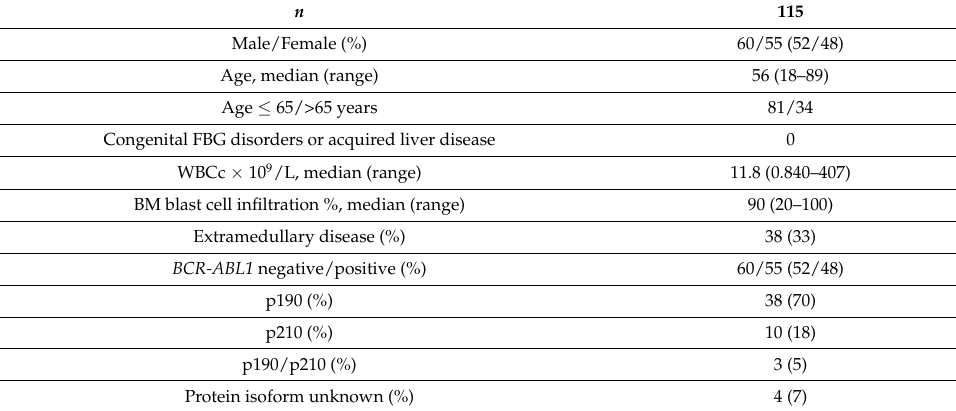
Table 1. Clinical and laboratory characteristics at